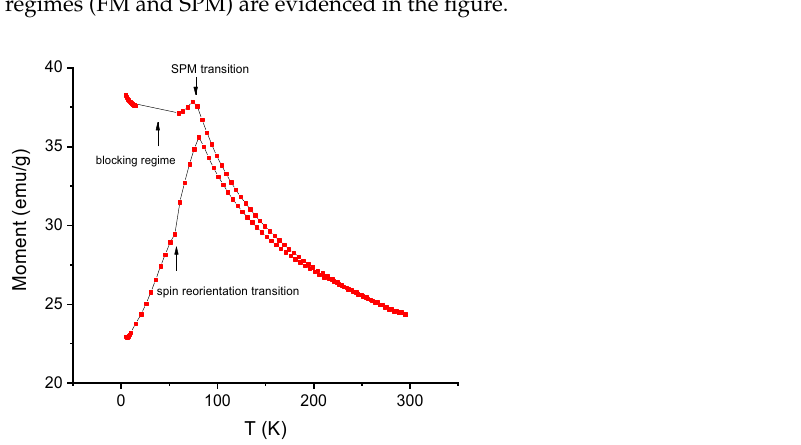
Figure 6. ZFC-FC curves of Mn 53 Al 45 C 2 sample. The blocking regime and the spin reorientation and SPM transitions are evidenced in the figure.